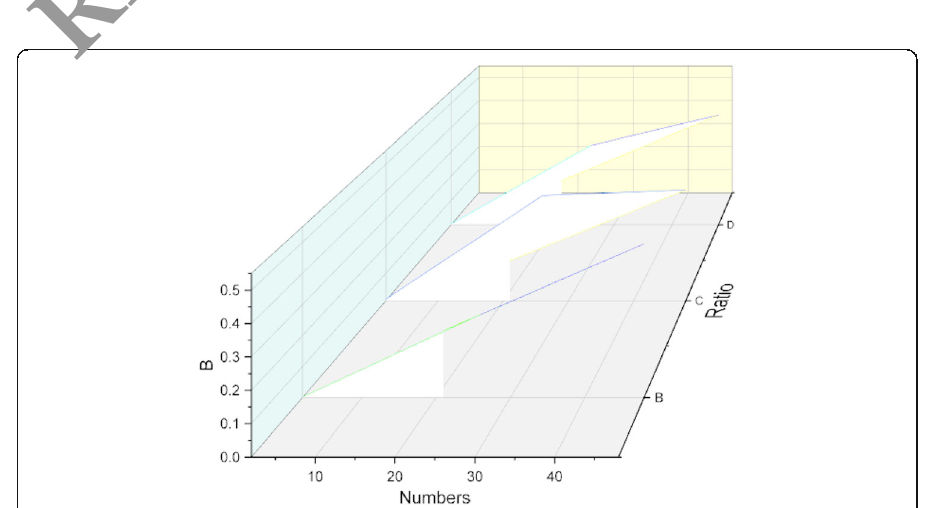
Fig. 3 Analysis of lexical